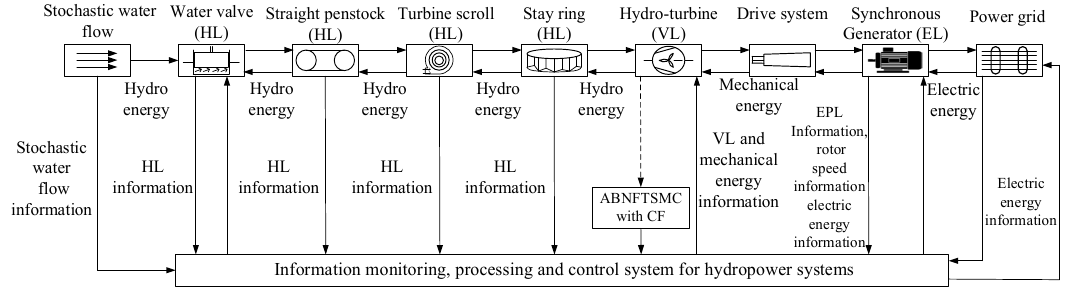
Figure 3. The schematic diagram of energy conversion and losses in a HS.